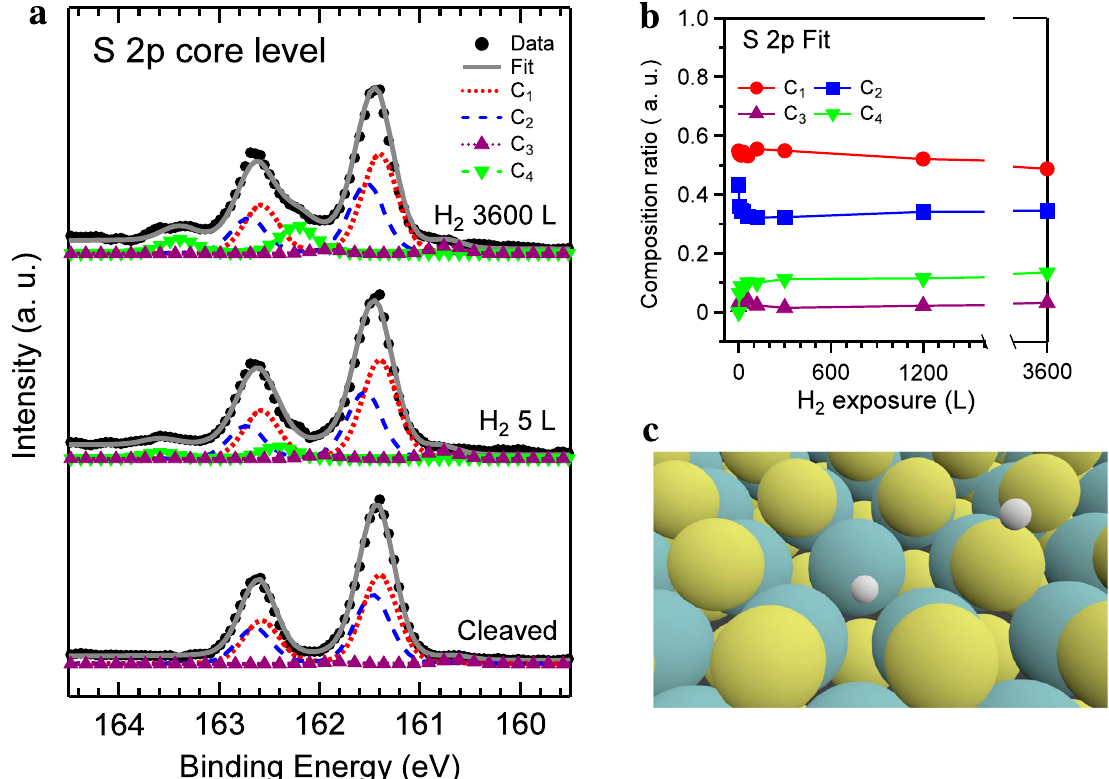
Figure 3. Evidence of the chemisorbed hydrogen at the S 2p core-level spectra. ( a ) S 2p core-level photoemission spectra (solid circles), obtained by the 2 nd light order of the photon energy of 100 eV, along with the curve-fitting results. ( b ) Plot of the relative intensity for the four components, C 1 (red), C 2 (blue), C 3 (green), and C 4 (purple) as a function of the H 2 exposure time. ( c ) Schematic of two absorbed H atoms with Mo and S atoms around the